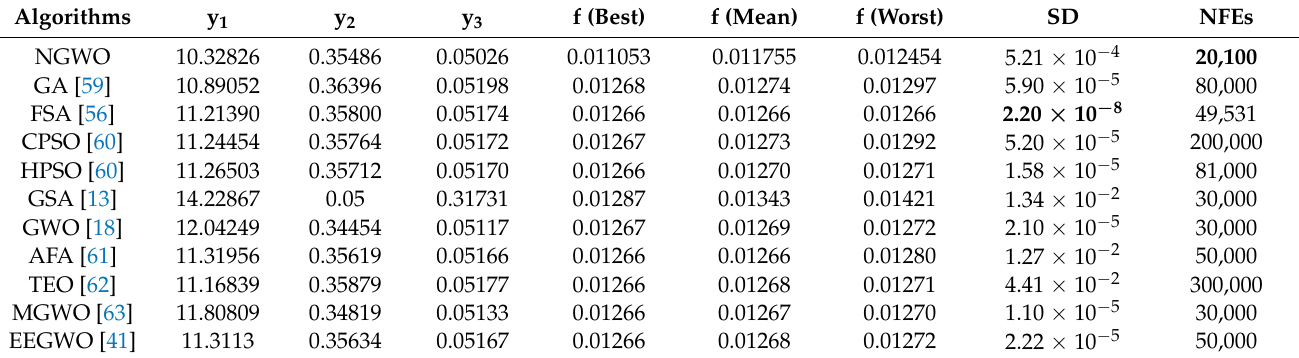
Table 7. Comparative study of tension–compression coil spring